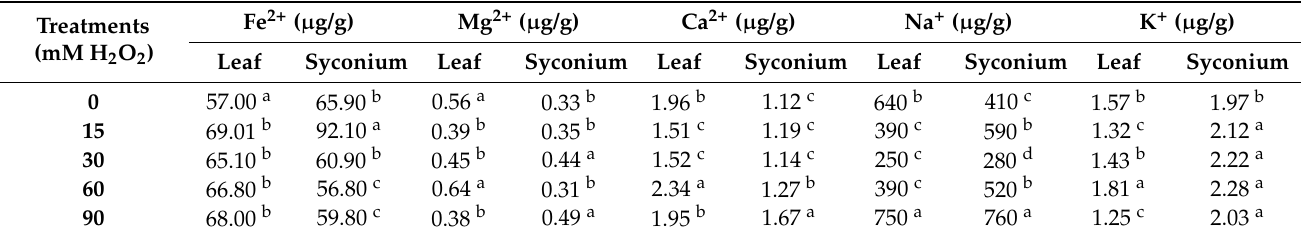
Table 5. Effects of H 2 O 2 on the nutrient content (Fe 2+ , Mg 2+ , Ca 2+ , Na +, and K + ) accumulation in the leaf and syconium of F. deltoidea plants.